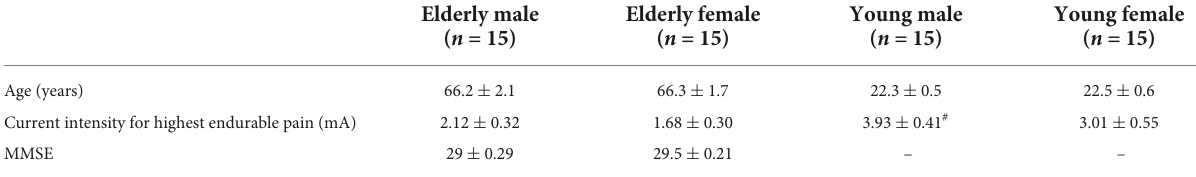
TABLE 1 Baseline data of the four participant groups.